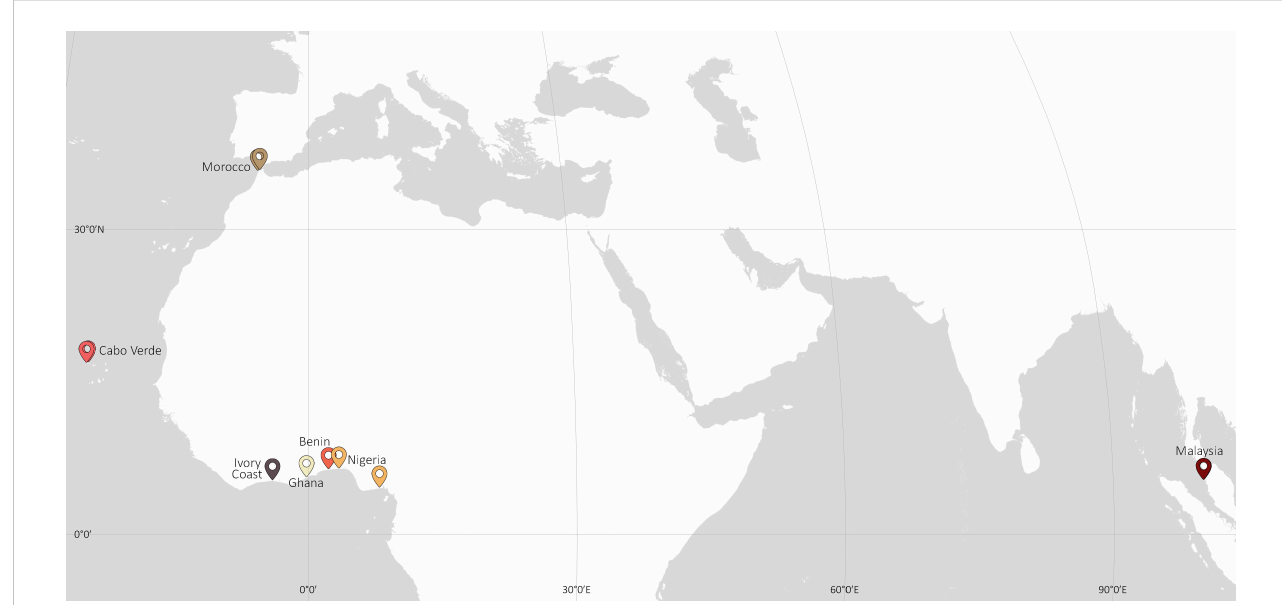
FIGURE 3 Sampling locations (red) of the project COLLECT in Benin (Abomey Calavi area), Cabo Verde (Calhau and São Vincente), Co ̂ te d ’ Ivoire (Port Bouet), Ghana (Accra area), Malaysia (Pantai Ombak Damai and Pantai Pasir Panjang), Morocco (Sidi Kacem and Sidi Kankouch beaches), and Nigeria (Ibeno Beach in Calabar area, and Lagos). Map by the Flanders Marine Institute (2020), World Countries